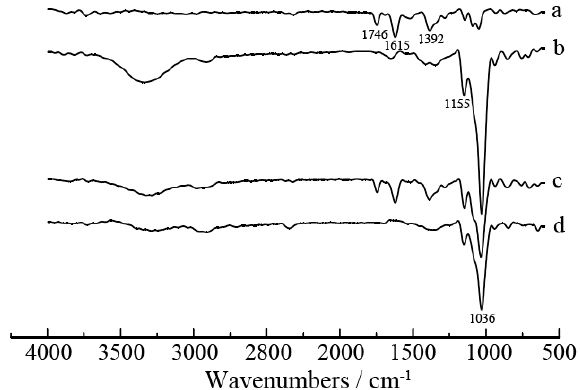
Figure 2. FT-IR spectrogram of tea polyphenols, β -cyclodextrin, tea polyphenols / β -cyclodextrin mixture and tea polyphenols- β -cyclodextrin inclusion complex. ( a ) Tea polyphenols; ( b ) β -cyclodextrin; ( c ) tea polyphenols / β -cyclodextrin mixture; ( d ) tea polyphenols- β -cyclodextrin inclusion complex.